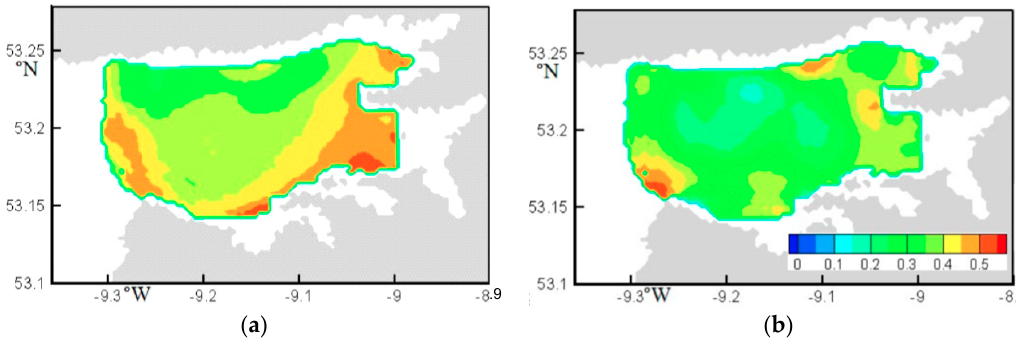
Figure 2. Pearson’s correlation coefficient between HFR data and model “Free Run”: ( a ) zonal; and ( b ) meridional direction for the month of December 2011 (from O’Donncha et al. [19]).